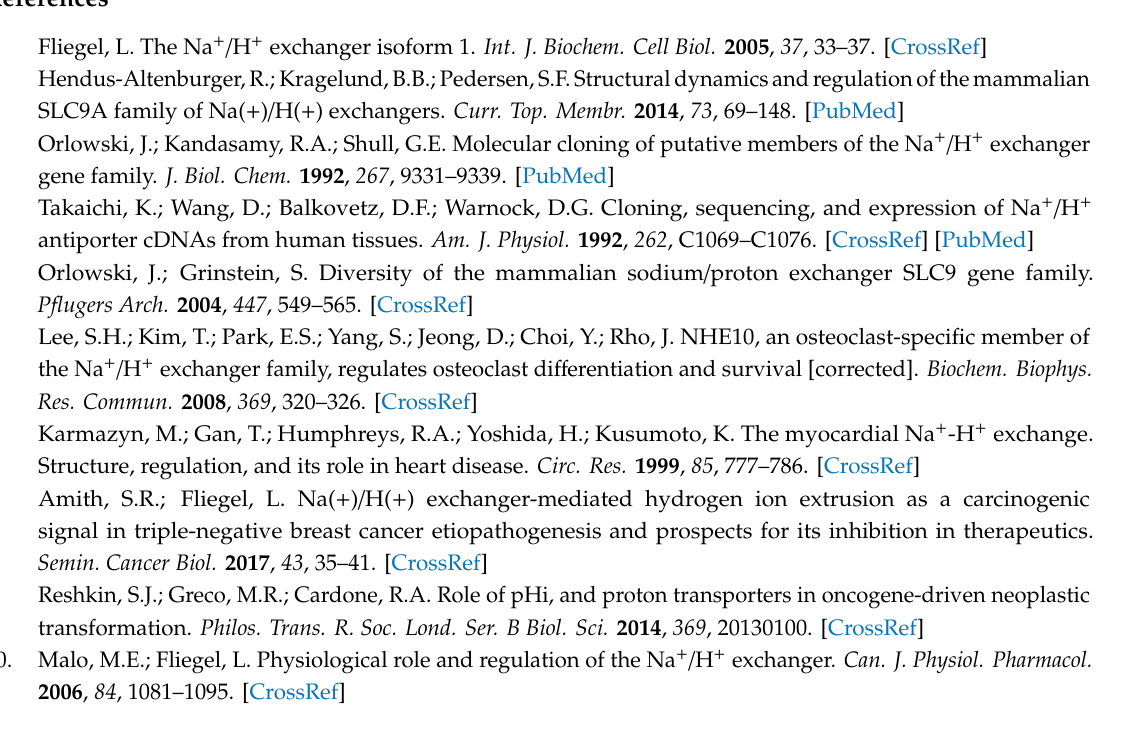
s1. Figure S1: Binding of synthetic peptide containing the N-GL IAGE RSYPYDVPDYAG (experimental) sequence or the peptide N- GLAAAARSYPYDVPDYAG (control). Quantification was using Image J. Results are the mean of at least 4 determinations. (A) Binding to the peptides of the dot blot numbers 1–33 beginning at amino acid 501. Each spot on the array contains a peptide of 15 amino acids in length. The adjacent peptide is shifted by 3 amino acids towards the C-terminal. Experimental, filled bars, Control, hatched bar. Sequences of the peptide array which bound to the probe are indicated. (B,C) as in A but with dot blot numbers 34–66 and 67–101 respectively. Figure S2: Binding of synthetic peptides (as in Figure S1) in comparison with hydropathy. Hydropathy was determined using the ExPASy Protein server, Kyte and Doolittle analysis with a window size of